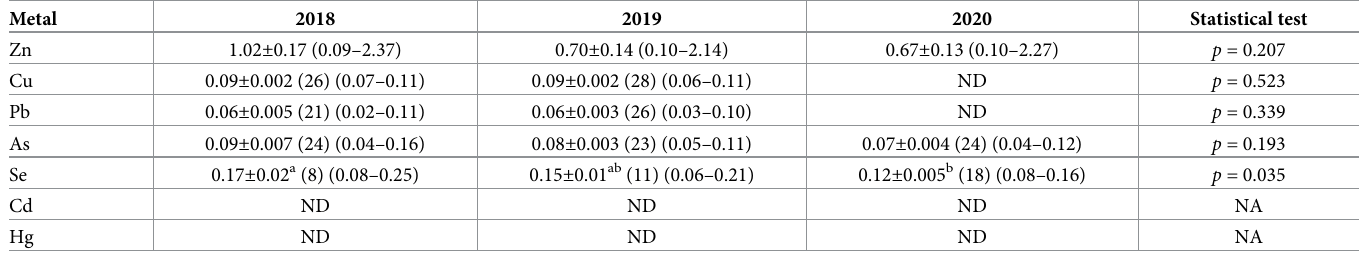
Table 3. Heavy metal concentrations (mean ± standar deviation, μ g g -1 wet weight) in blood of nesting Kemp´s ridleys ( Lepidochelys kempii ) from Rancho Nuevo, Mexico, 2018–2020.